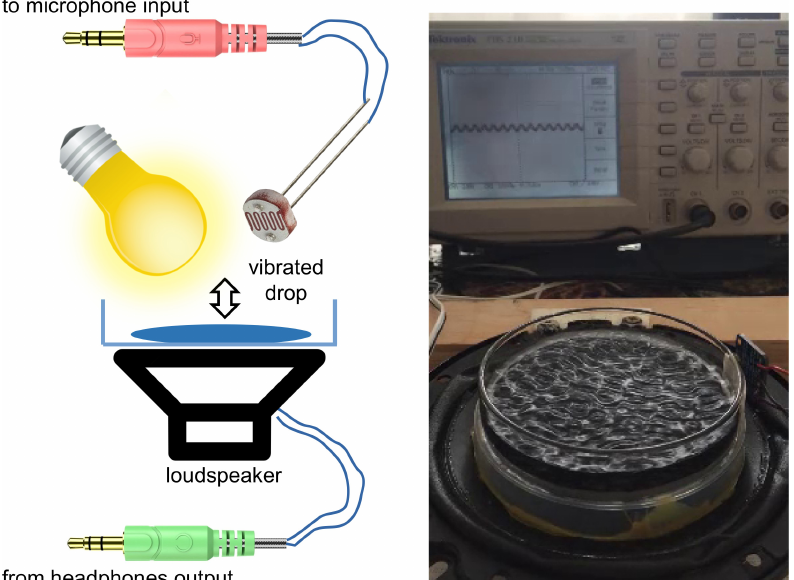
Figure 17. ( Left ) Schematic of a technically simple experimental setup consisting of a low-frequency loudspeaker connected via a power amplifier to the headphone output of a laptop computer. A Petri dish is glued to the loudspeaker. An audio signal is produced by a tone generator. The fluid surface is illuminated by a light source and Faraday waves are detected using a photoresistor that is connected either to an oscilloscope or to the microphone input of the laptop computer with a pre-installed audio signal processing software. ( Right ) Photograph of Faraday waves on the surface of water contained in a Petri dish glued to a vibrating